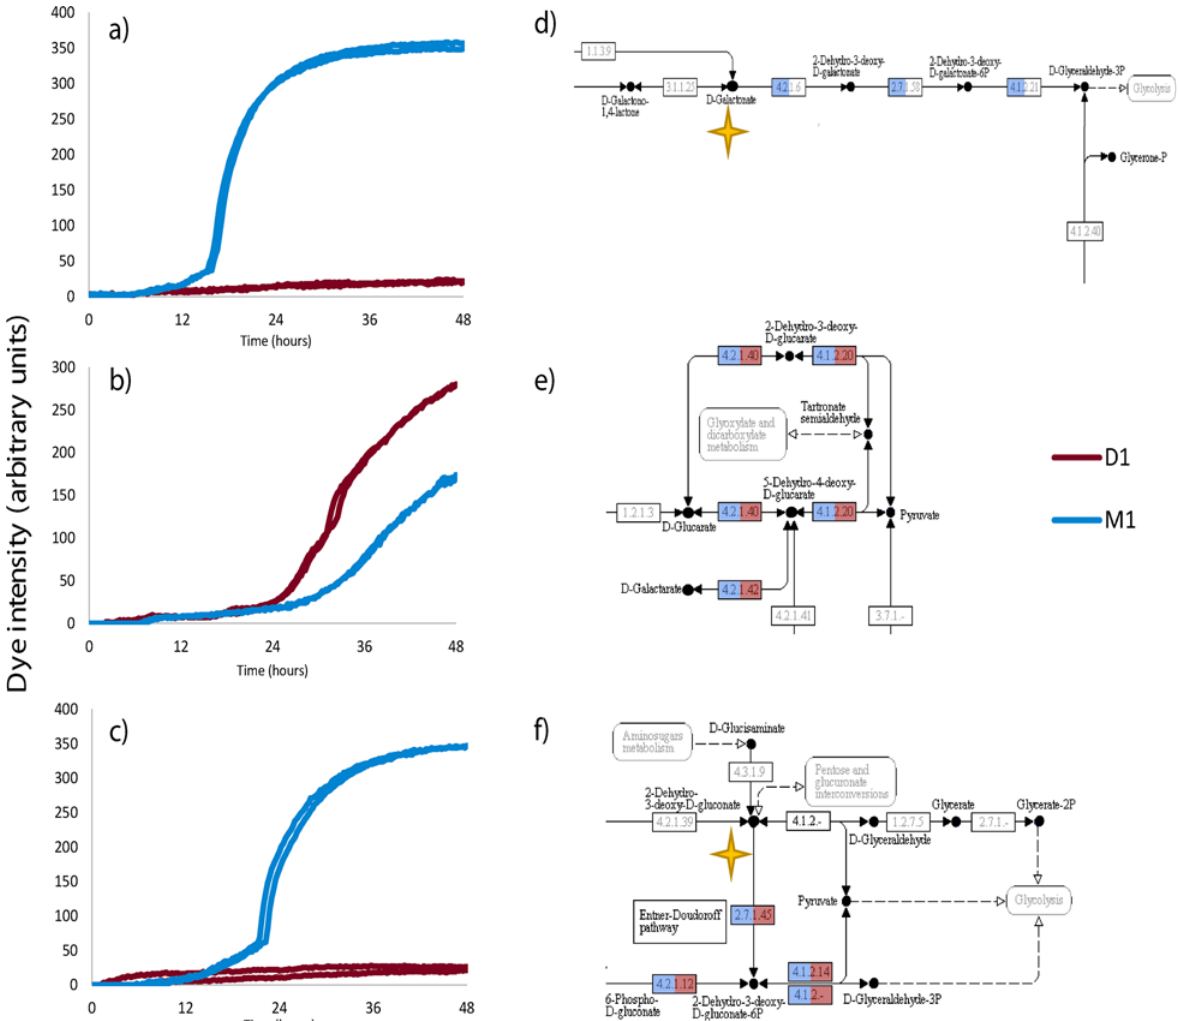
Fig 1. Relationship between respiratory response and metabolic pathways of S. Derby and S. Mbandaka. Respiratory responses which distinguish S . Derby and S . Mbandaka under aerobic conditions at 25°C and the corresponding metabolic pathway for the metabolism of the compound from uptake to glycolysis. Only S . Mbandaka respires on D-galactonic acid-g-lactone (DGL) (a), this can be attributed to the lack of pathway genes (e) (KEGG map 00052, created 31/5/12). Likewise, S . Derby is unable to respire on D-glucosaminic acid (DGA) while S . Mbandaka can (c) yet both serovars possess the same pathway genes (g) (KEGG map 00030, created 9/3/13). For both DGL and DGA there were gaps in the SEEDmodel reconstruction which prevented the metabolism of the compounds, these were filled using ECBLAST and SEEDviewer BLASTp (yellow stars). Both serovars contain the same pathway genes for the metabolism of mucic acid (f) (KEGG map 00053, created 28/9/09) yet the area under the respiratory curve for this compound, and not the log phase gradient or lag phase, was significantly greater for S . Derby